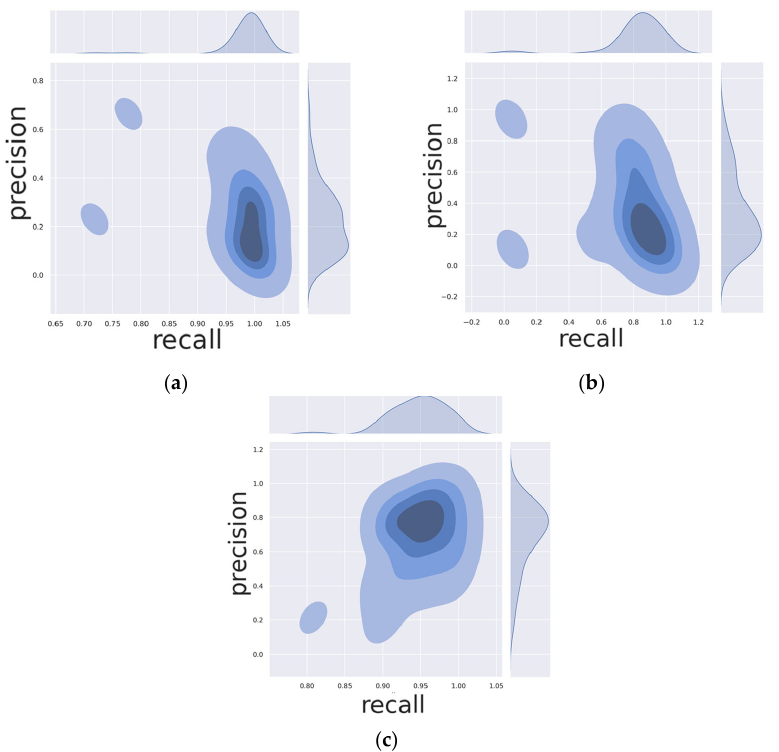
Figure 6. The kde graph of precision and recall. ( a ) The kde graph of LSD, it can be seen that the recall is more concentrated and achieved the best recall among the three methods. ( b ) HoughP is similar to the LSD method, and the distribution of the precision is more dispersed, which means the inner uncertainties in practical application. ( c ) Our method is closer to the top-right corner in distribution; it could be a little scattered, but it has the best precision score. As is shown in Figure 7, it is hard for traditional methods to distinguish the target line and the line in the background. With a more complex background, the more the meth- ods are susceptible to noise. It should be noted that, for an image with simple background and foreground objects, such as Figure 7b–d, as can be seen, regardless of spli tt ing one segment into several line segments, the traditional methods showed a great performance. in Figure 7a,d.